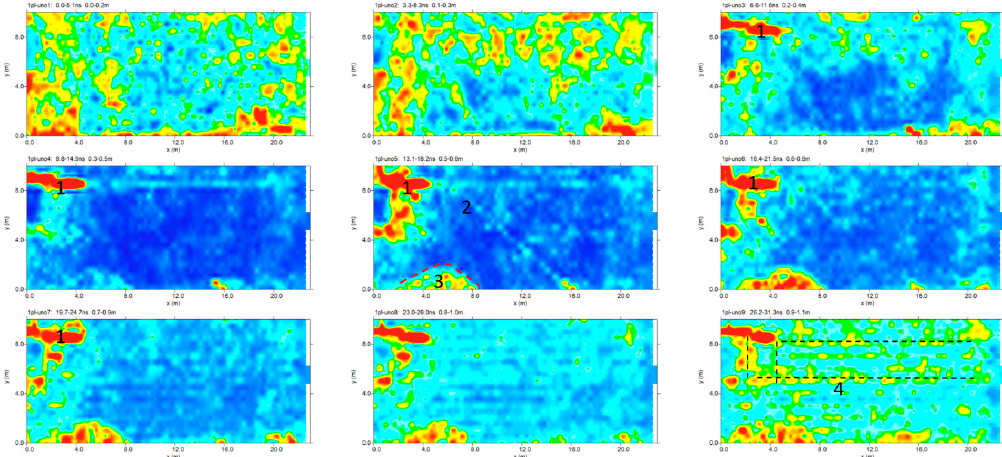
Figure 8. Plaza de Armas: sector 1: time slices in which some alignments are highlighted.